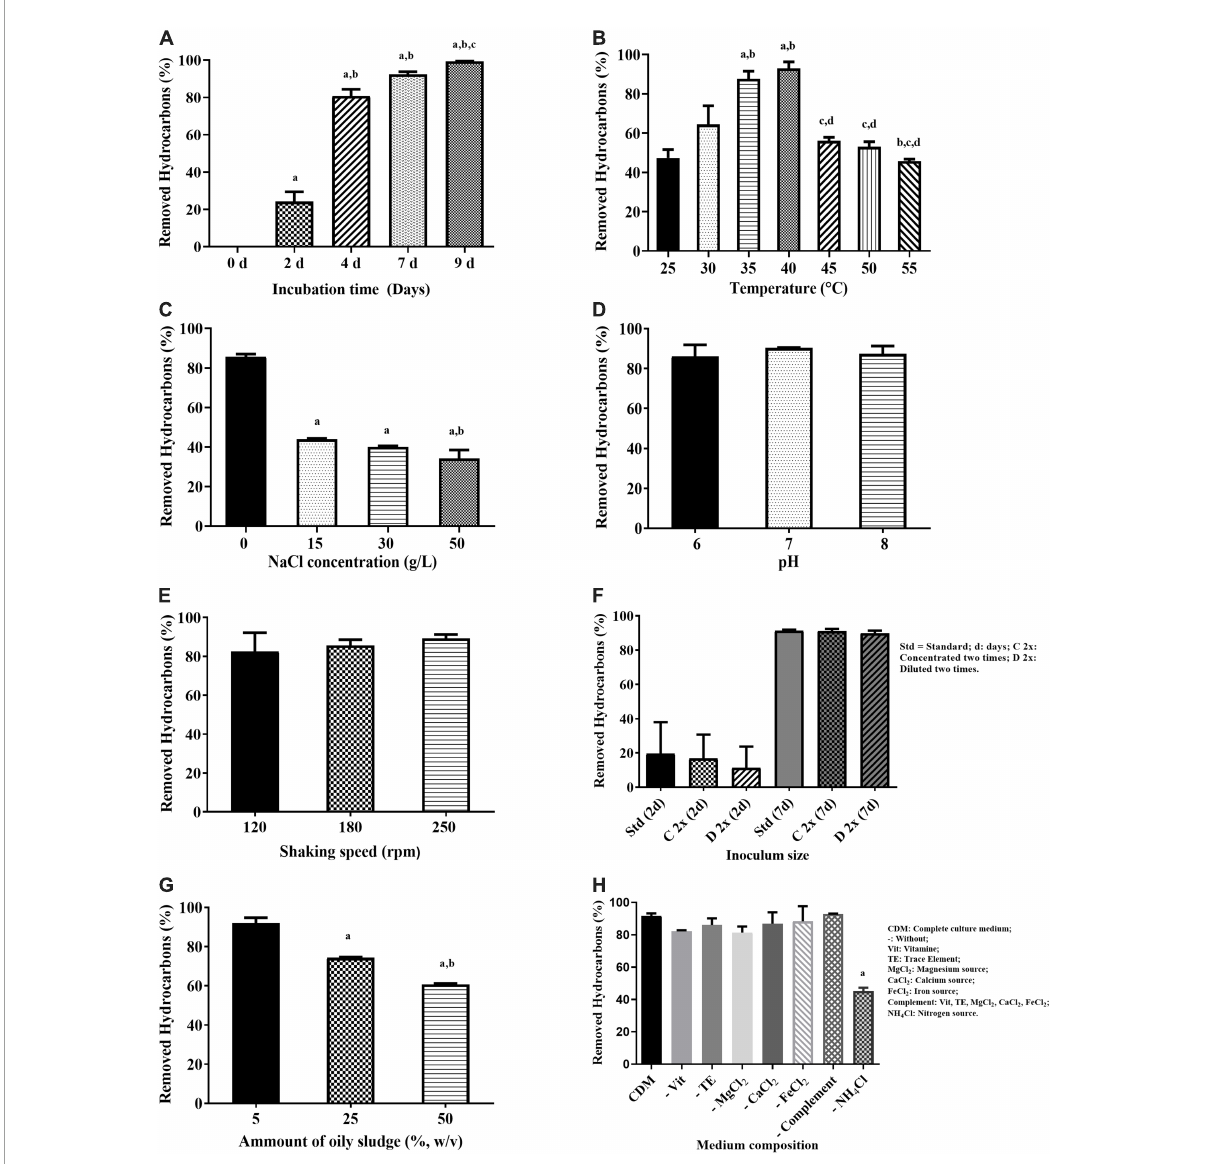
FIGURE2 Evaluation of the effect of incubation time (A) , temperature (B) , NaCl concentration (C) , pH (D) , shaking speed (E) , inoculum size (F) amount of oily sludge (G) , and culture medium composition (H) on the biodegradation of oily sludge by mixed culture AK6. Values given represent the mean of two replicates ± standard deviation. vs: versus. (A) a p < 0.05 at 0 day vs. other incubation times; b p < 0.05 at 2 days vs. other incubation times; c p < 0.05 at 4 days vs. other incubation times; (B) a p < 0.05 at 25 ◦ C vs. other temperatures; b p < 0.05 at 30 ◦ C vs. other temperatures; c p < 0.05 at 35 ◦ C vs. other temperatures; d p < 0.05 at 40 ◦ C vs. other temperatures; (C) a p < 0.05 at 0 g/L NaCl vs. other salinities; b p < 0.05 at 15 g/L NaCl vs. other salinities; (G) a p < 0.05 at 5% oily sludge vs. other oily sludge concentrations; b p < 0.05 at 25%